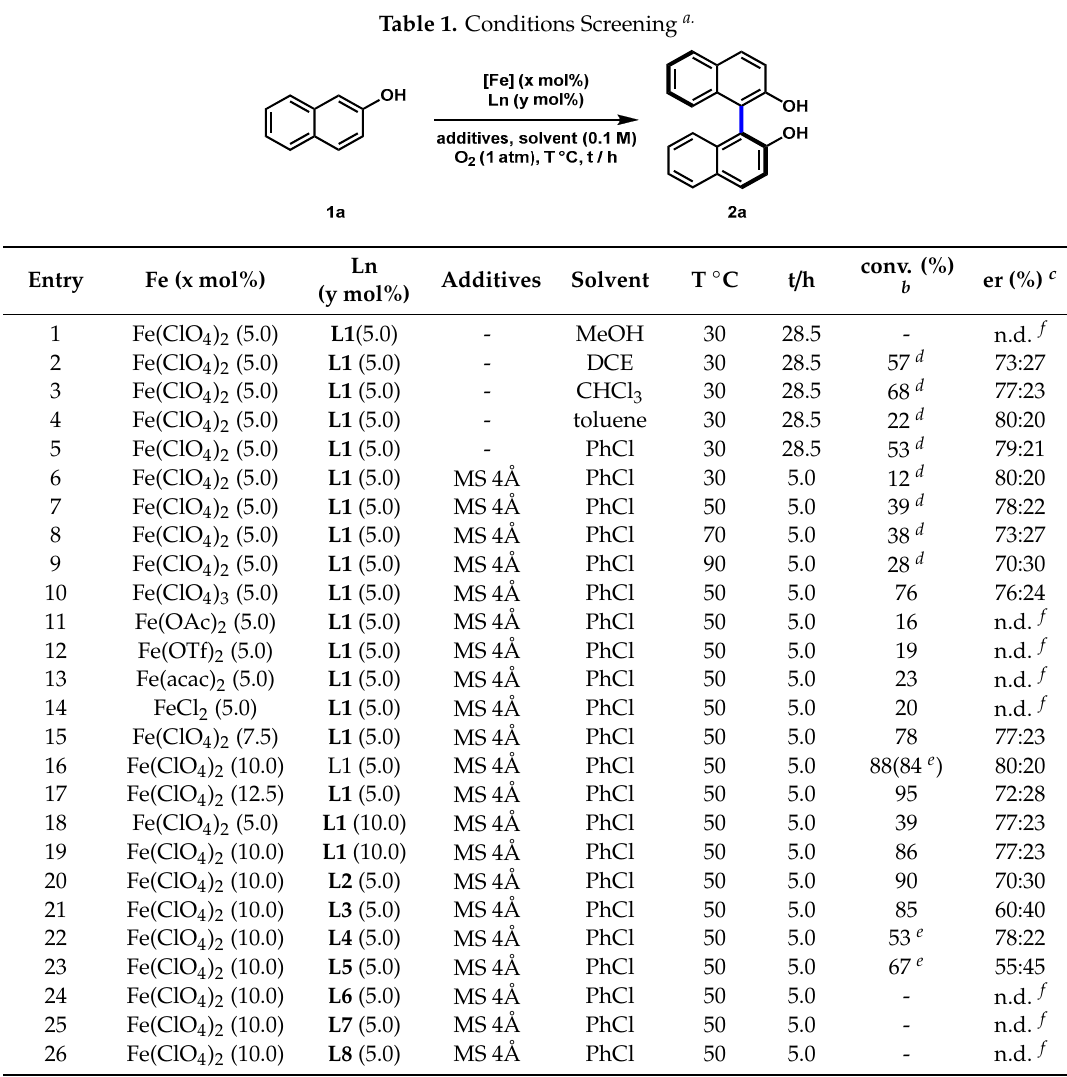
Table 1 . Conditions Screening Table 1. Conditions Screening a.